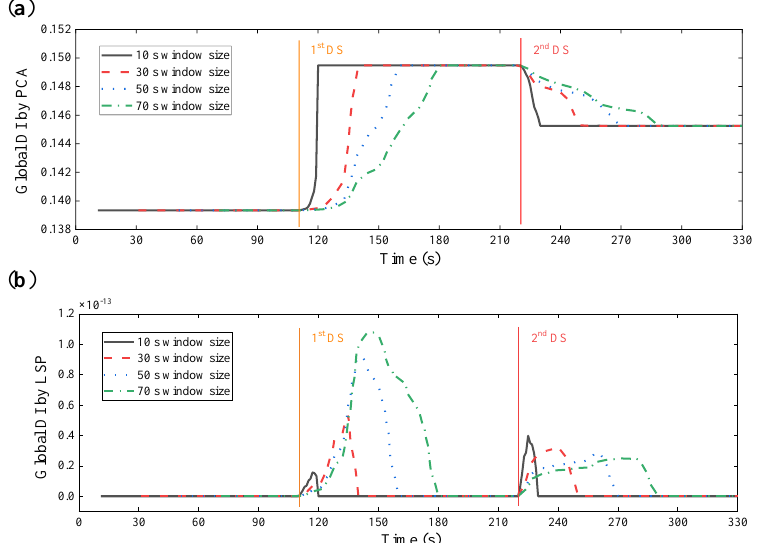
Figure 12. Results of damage detection using WPES-based ( a ) PCA and ( b ) LSP methods respectively, with different window sizes (10, 30, 50, and 70 s).